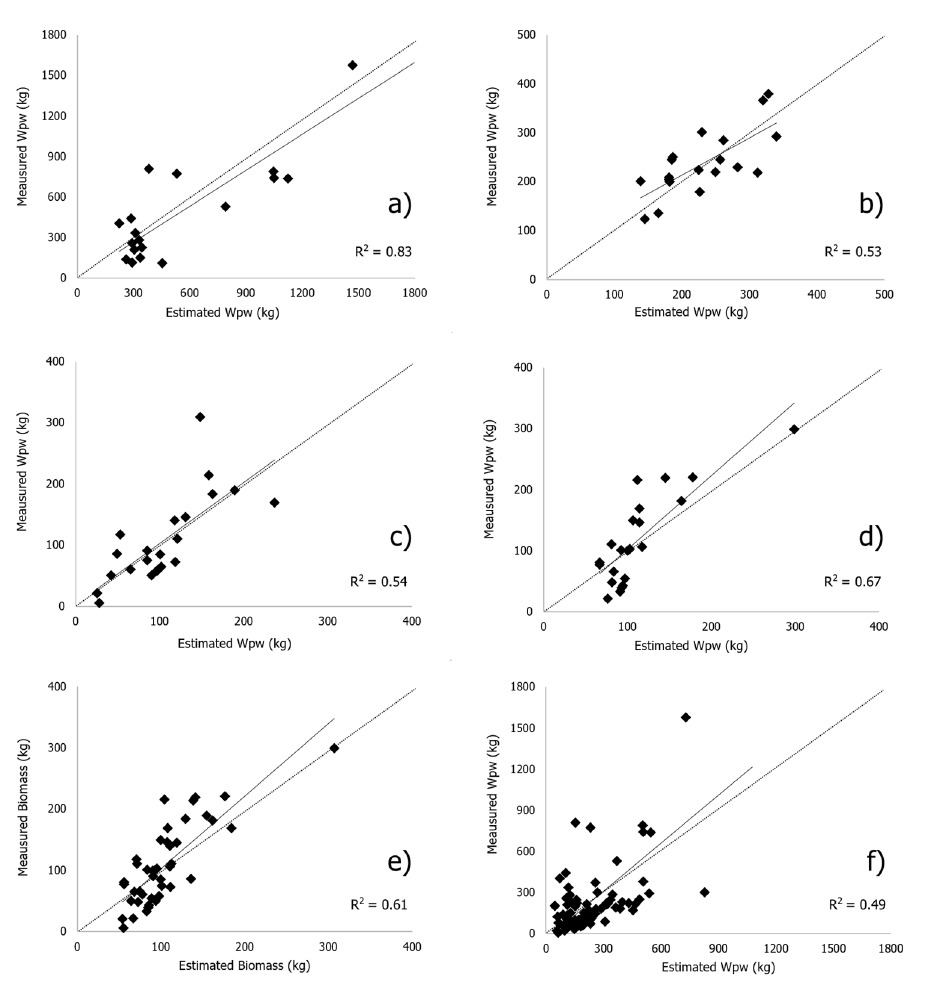
Figure 6. Wpw estimation validation by means of a comparison between measured and estimated Wpw retrieved by the unsupervised segmentation within site A ( a ), B ( b ), C ( c ), D ( d ), C + D ( e ) and A + B + C + D dataset ( f ).